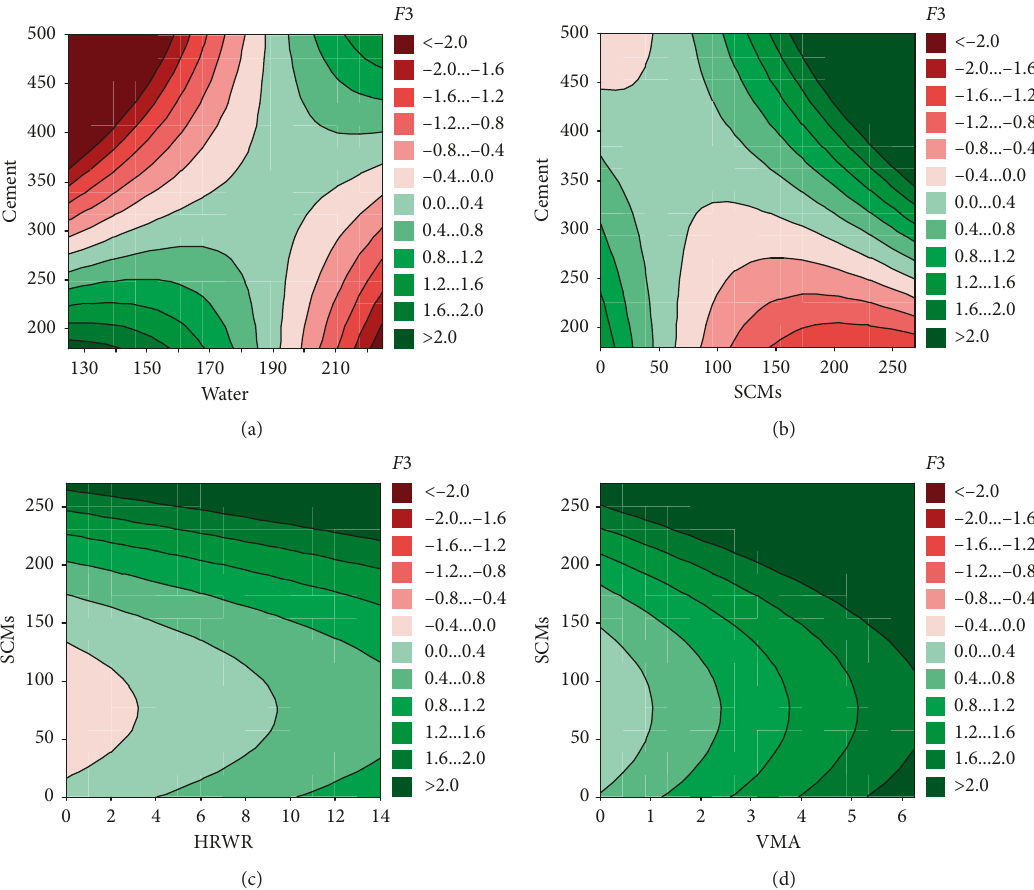
Figure 7: Stability of the fresh mix with respect to changes in paste composition ( F